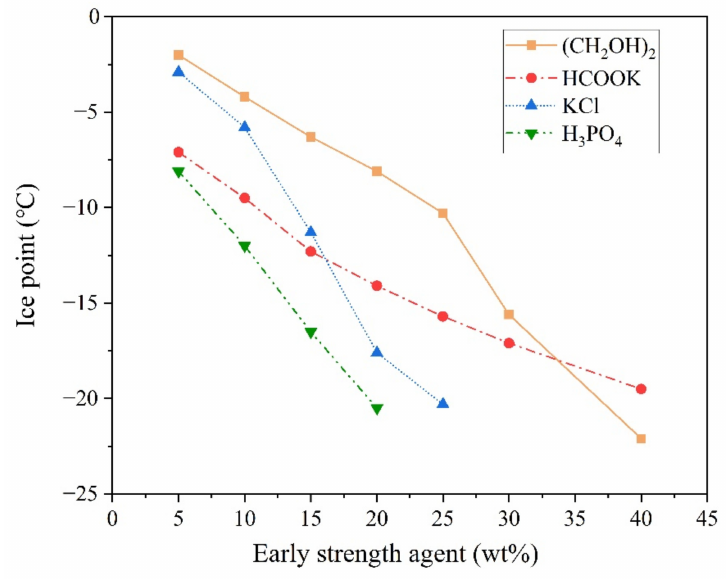
Figure 1. The freezing point of mixing water containing antifreeze